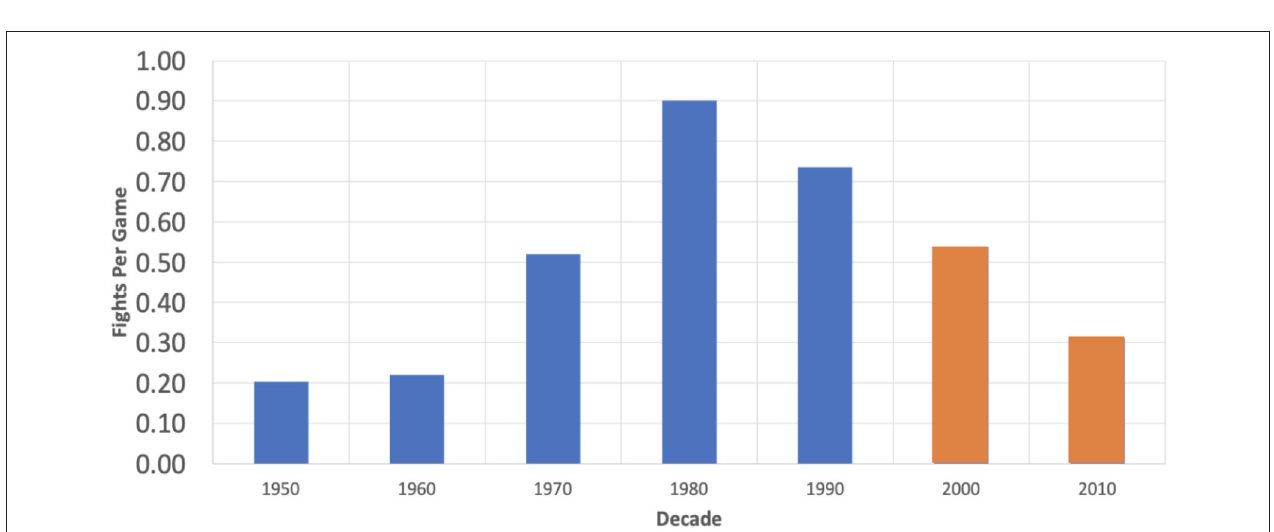
FIGURE 1 | Graph comparing rates attendance and fighting in the NHL during the period of 2000–2020. Average attendance per game is reported on the first Y- axis while the number of fights per game is denoted on the second Y- axis. The NHL season is listed on the X-axis with the year representing when the Stanley Cup championship was held for each season. For example, the 2000–2001 NHL season is listed as 2001, as the Stanley Cup championship for that season was held in the spring of 2001. This plot demonstrates the trend of decreasing fighting rates and increasing attendance during the last 20 years. Note the entire 2005 season was canceled due to a lock-out.